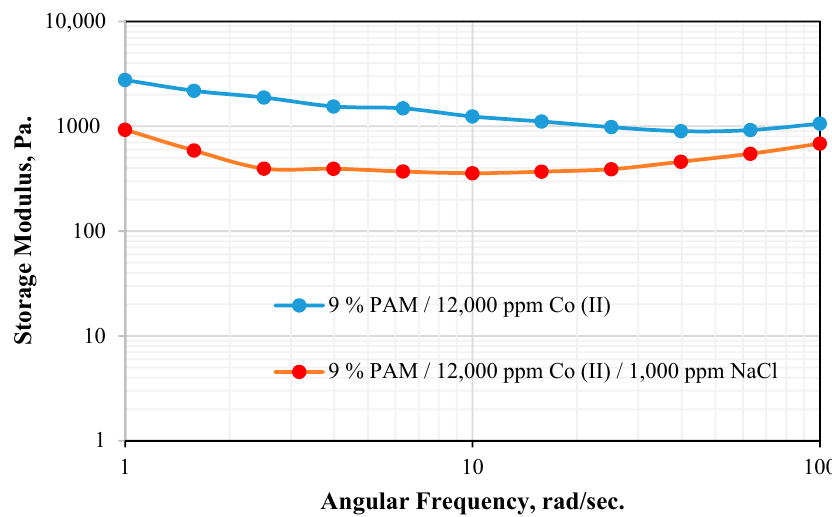
Figure 14. E ff ect of adding 1000 ppm NaCl on the storage modulus of the gel (T = 25 ◦ C). Figure 14. Effect of adding 1000 ppm NaCl on the storage modulus of the gel (T = 25 °C).